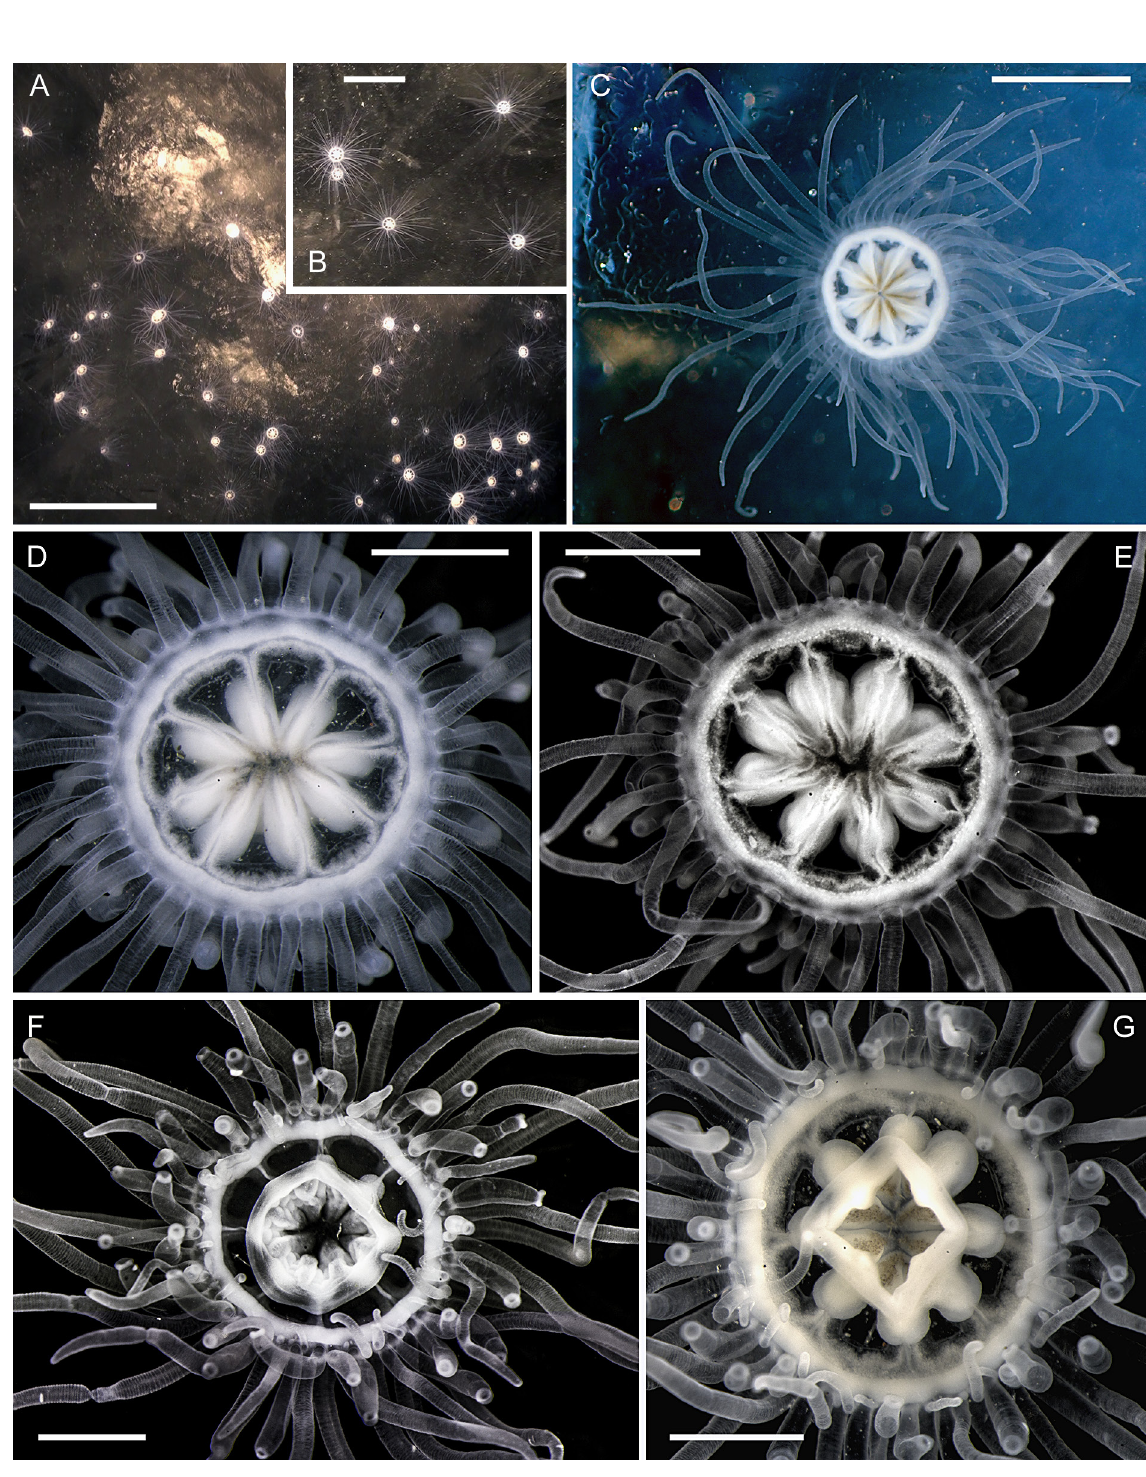
Fig. 1. Glaciambulata neumayeri Galea, Roder, Walcher, Warmuth, Kohlberg & Fischer, gen. et sp. nov. A – C . Living medusae. D – G . Preserved medusae in aboral (D, E) and oral (F, G) views. Scale bars: A, C = 5 mm; B, D–G = 2